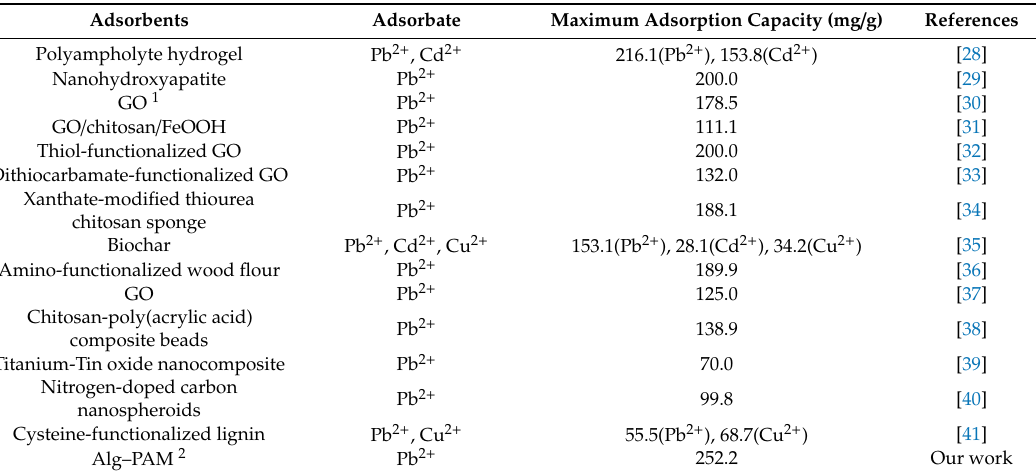
Figure 7. Maximum adsorption capacity of the Alg–PAM for Pb 2+ . Table 2. Adsorption capacities of the reported adsorbents for Pb 2+ .